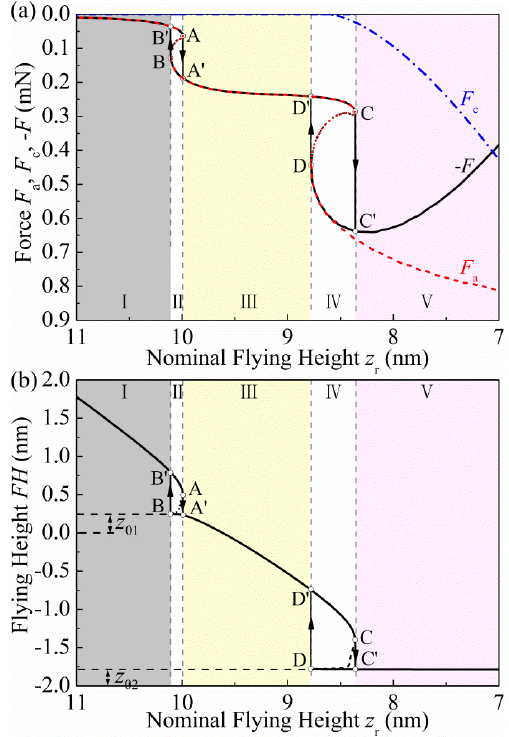
Figure 6. Variations of force and flying height with the nominal flying height under l c = 10 nm, t lub = t DLC-disk = t DLC-slider = 2 nm: ( a ) Adhesion force F a , Contact force F c , Net force F and ( b ) Flying height FH .